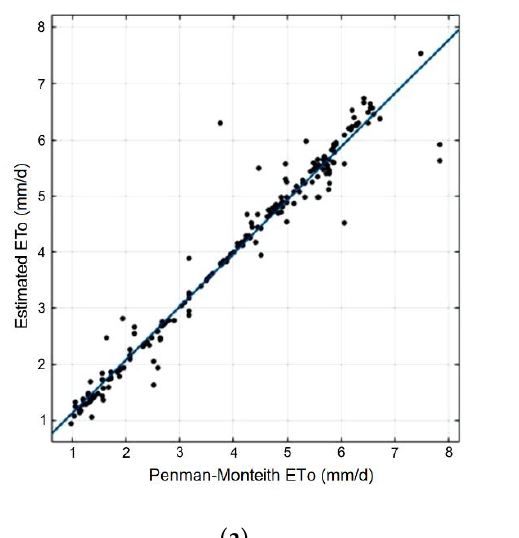
Figure 7. Error histogram of the RFC + K* regression model in the estimation of ETo. The accuracy measures prove that the proposed method is able to achieve a very precise estimation of ETo, with an average error below 6.5% in relative terms. Thus, a good estimation of ETo can be obtained with a cost-effective system that would only require moisture sensors and agroclimatic data. Since the selected RFC method relies on subspace projections, we performed a principal component analysis (PCA) of the independent variables. It was observed that, from the 43 input variables, the first principal component (PC) accounted for only a 32% of the variance, and the second PC accounted for 13%. This indicates a high complexity in the distribution of the input data.